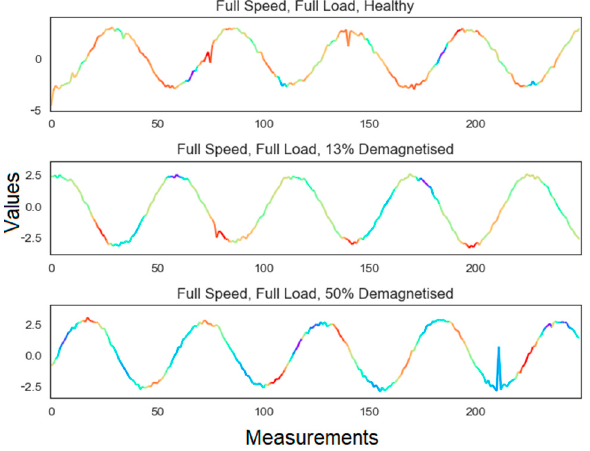
Figure 14. Class Activation Map (CAM) of the Health State model.